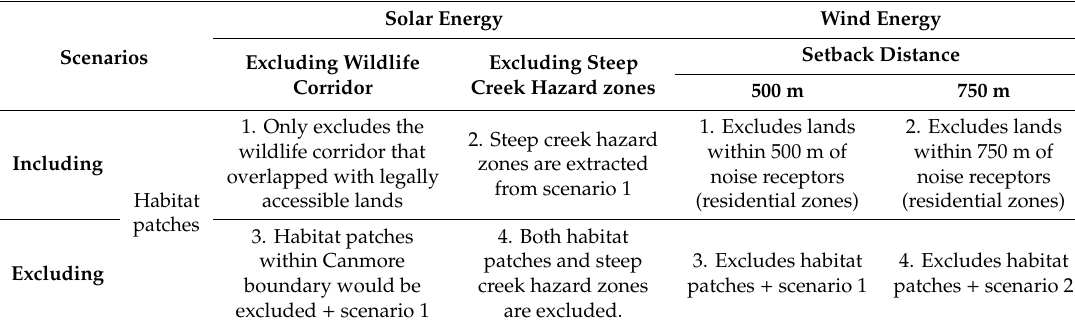
Table 2. Scenarios for potential solar and wind energy